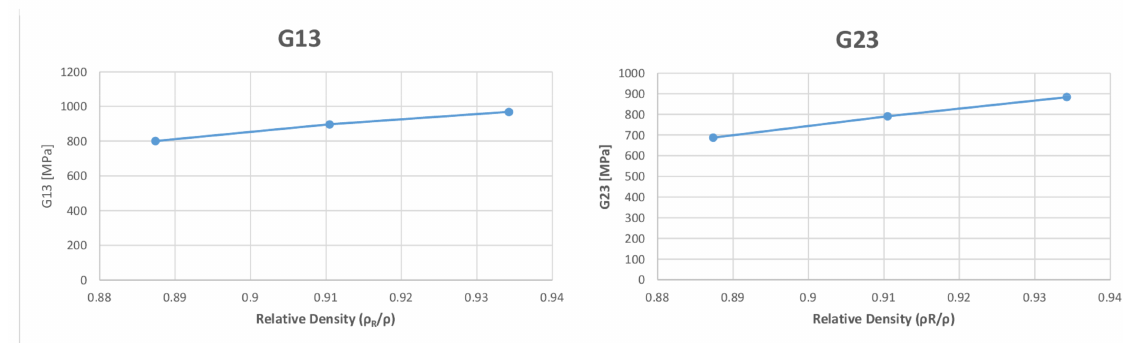
Figure 9. Variations of Young’s modulus and the Shear modulus with respect to the relative density. Consequently, shear moduli G 12 , G 13 , and G 23 were reduced compared to those in the case of a homogeneous isotropic material and strictly depended on the contact behavior between layers and lines. The displacements and directional stresses of all the load cases to show the symmetric behavior of the RVE are reported in Figures 10–15.